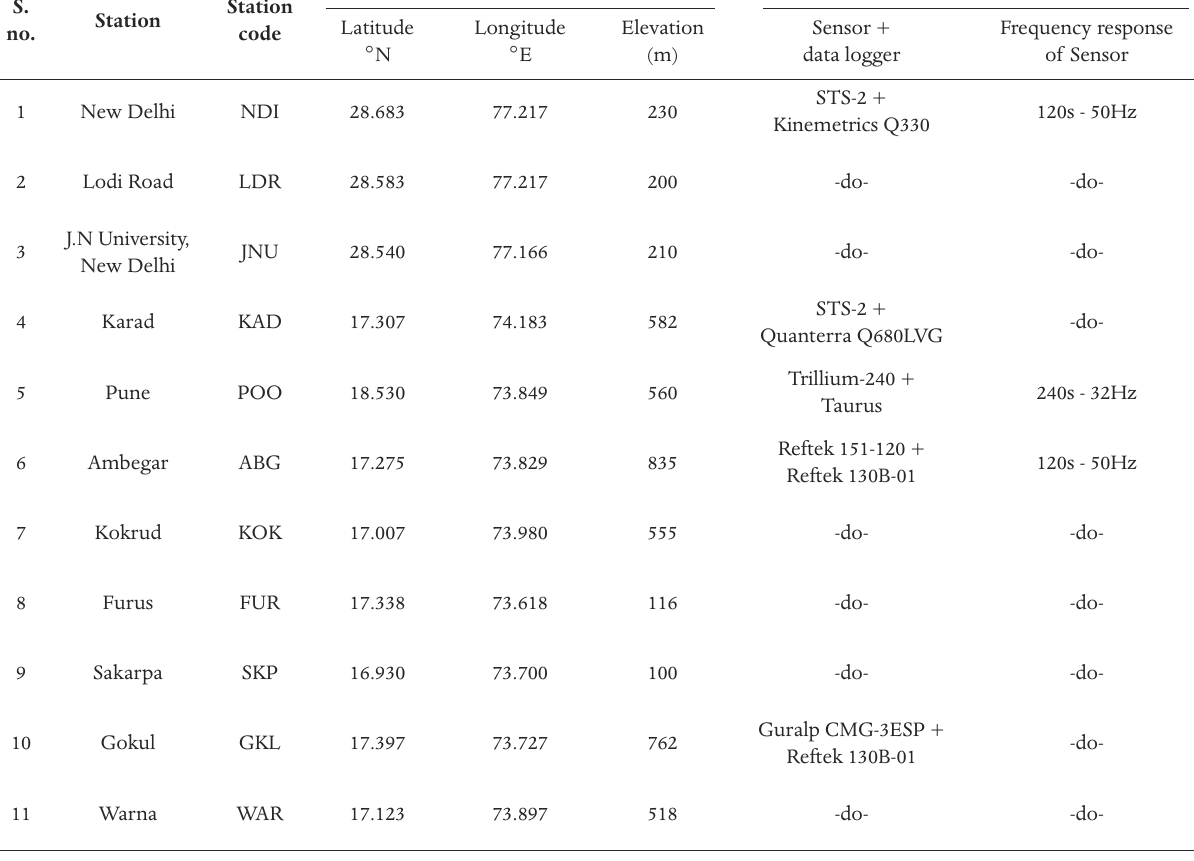
Table 1. List of stations